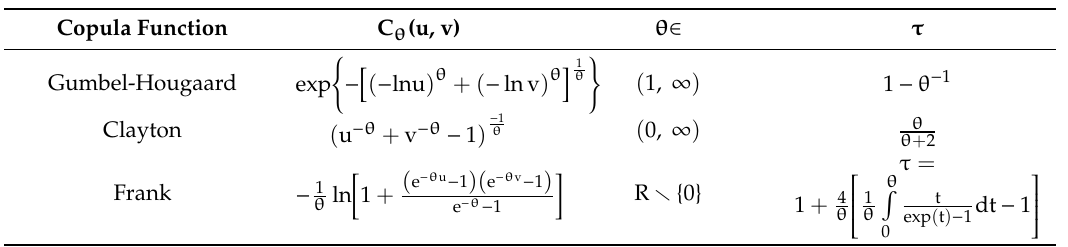
Table 2. Bivariate copula functions and the association between their parameters and Kendall correlation coe ffi